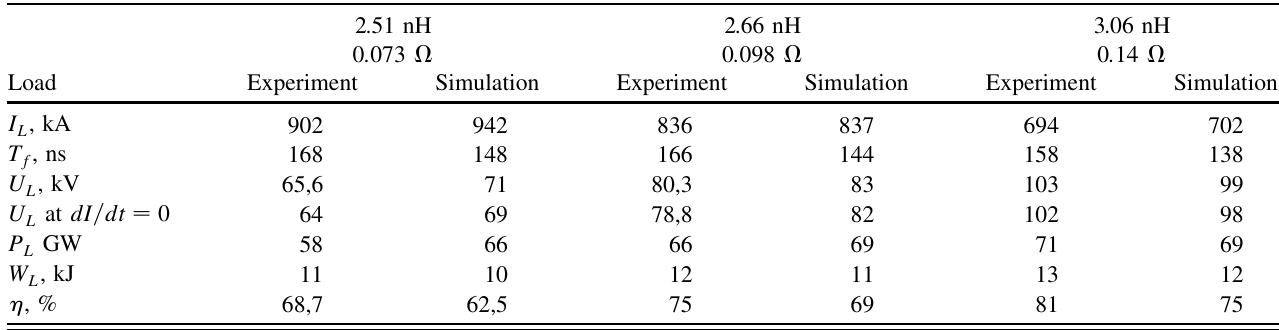
TABLE II. Results of investigations of the linear transformer from two stages. Here I L is current amplitude, T f is rise time, U L is load voltage, P L is load power, W L is load energy, and (cid:2) is efficiency of the energy transfer to a load.